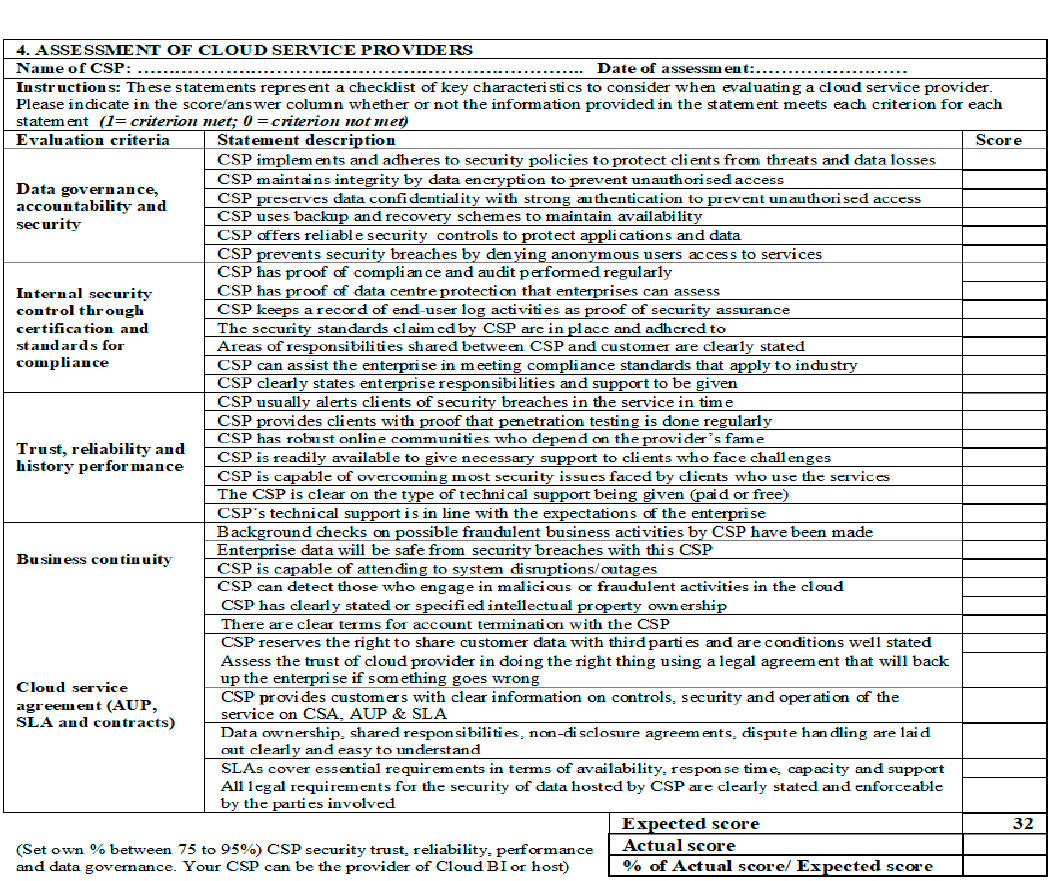
Figure 10. Checklist for selecting cloud deployment model.